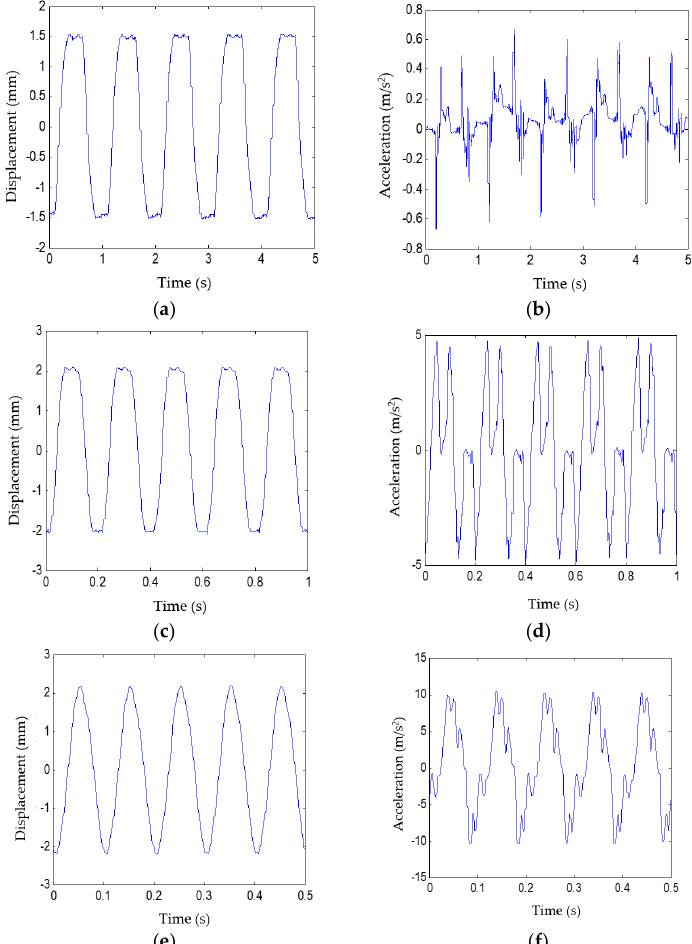
Figure 12. Pipeline vibration response under sinusoidal excitation frequency of 1, 5, 10 Hz without control: ( a ) Displacement-time curve (1 Hz); ( b ) Acceleration-time curve (1 Hz); ( c ) Displacement-time curve (5 Hz); ( d ) Acceleration-time curve (5 Hz); ( e ) Displacement-time curve (10 Hz); ( f ) Acceleration-time curve (10